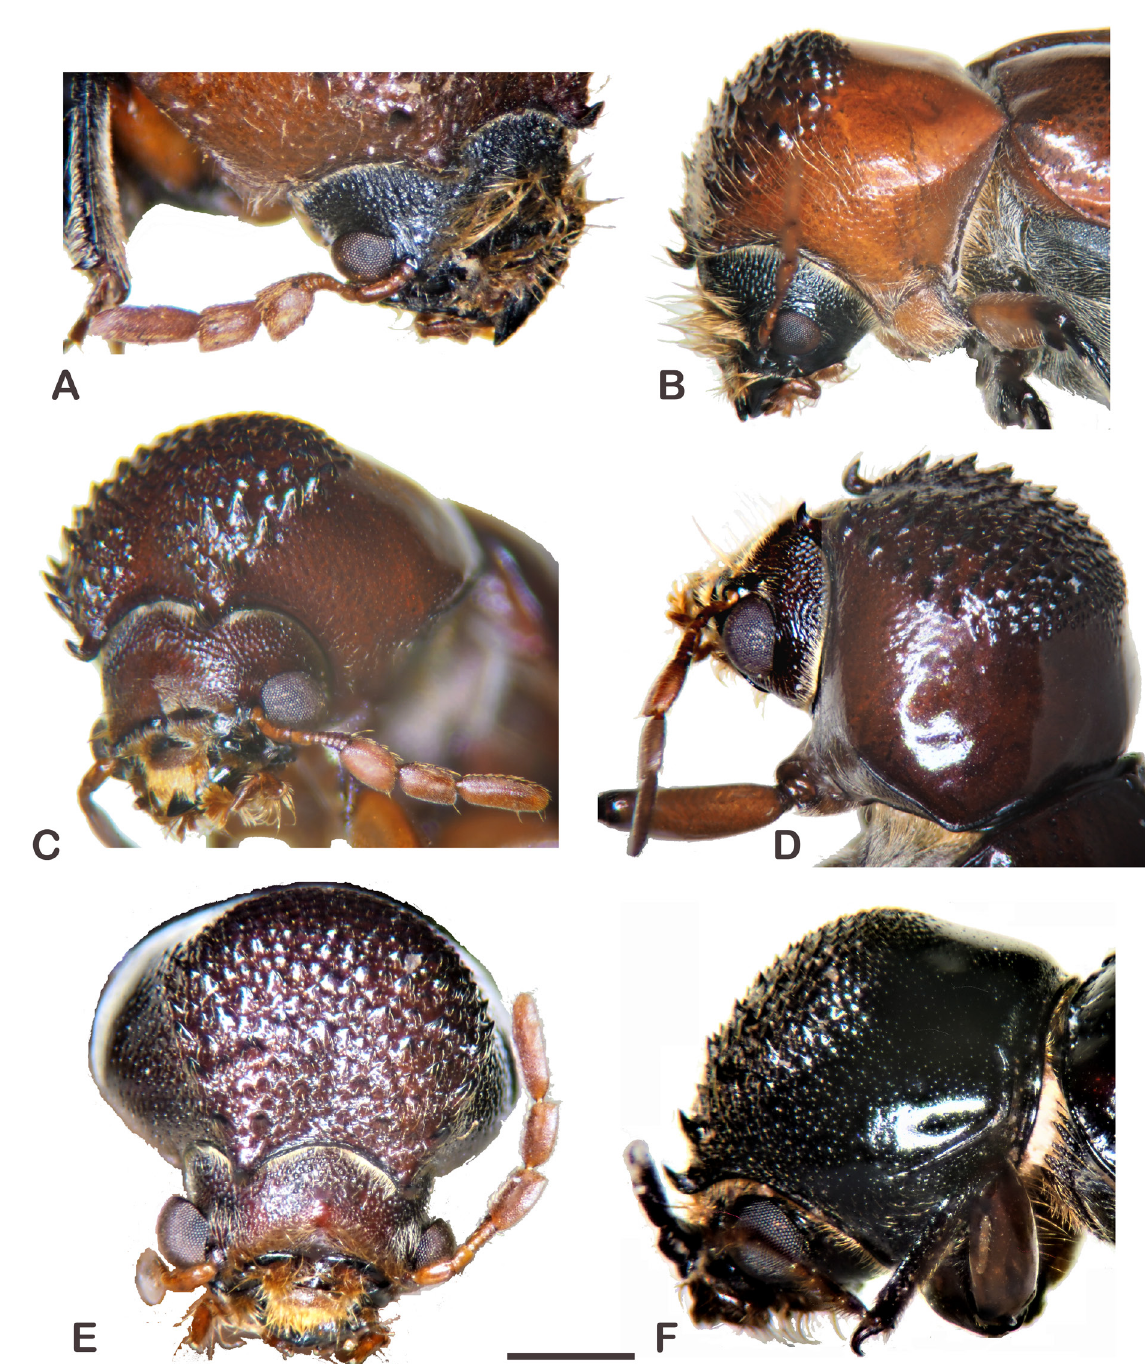
Fig. 1. A–B . Calophagus pekinensis Lesne, 1902, ♀ (SNSD). A . Anterolateral view showing the antennae, with two strips of golden hairs on sides. B . Lateral view of head and pronotum showing absence of lateral carina on pronotum. C–D . Xylothrips flavipes (Illiger, 1801), ♂ (LYL). C . Frontal view showing the antennae, matt without sensory areas. D . Lateral view of head and pronotum showing clear lateral carina on pronotum. E–F . Xylothrips religiosus (Boisduval, 1835), ♂ (LYL). E . Frontal view showing the antennae, matt without sensory areas. F . Lateral view of head and pronotum showing clear lateral carina on pronotum. Scale bar = 1